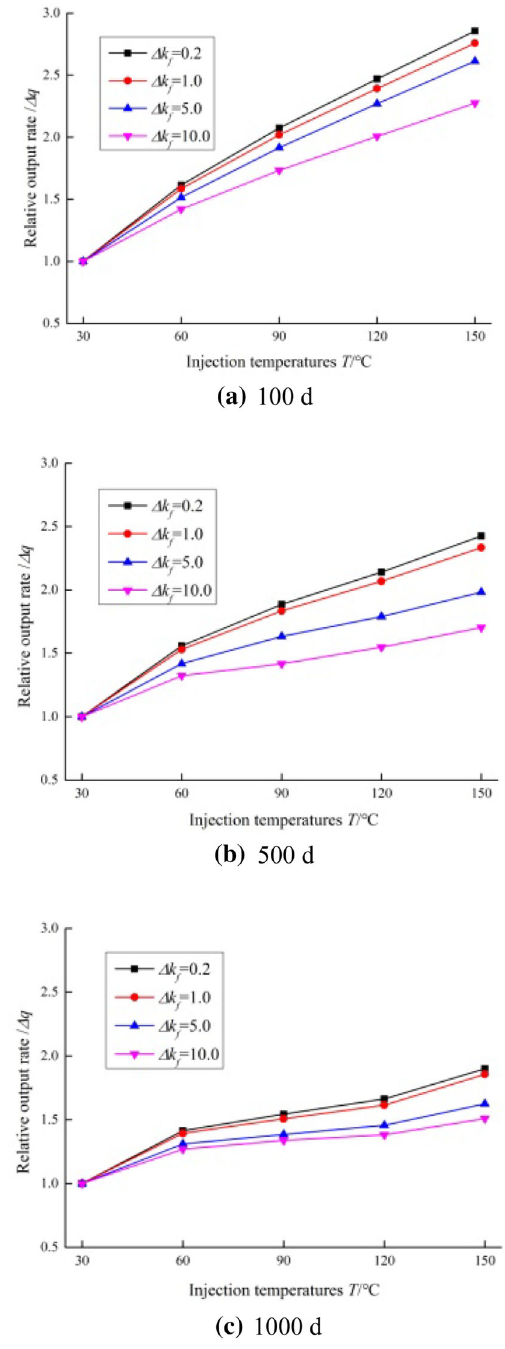
Fig. 12 Relative drainage rate at three typical drainage times in coal seams with different injection temperatures and